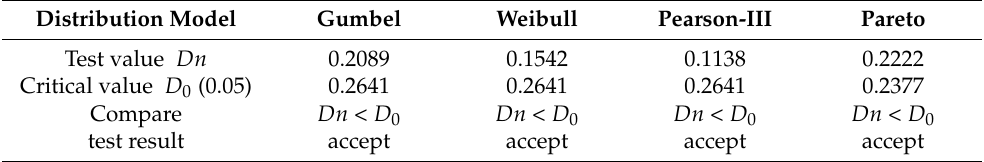
Table 1. K-S test of the distribution models of wave height series ( ∆ t = 12).